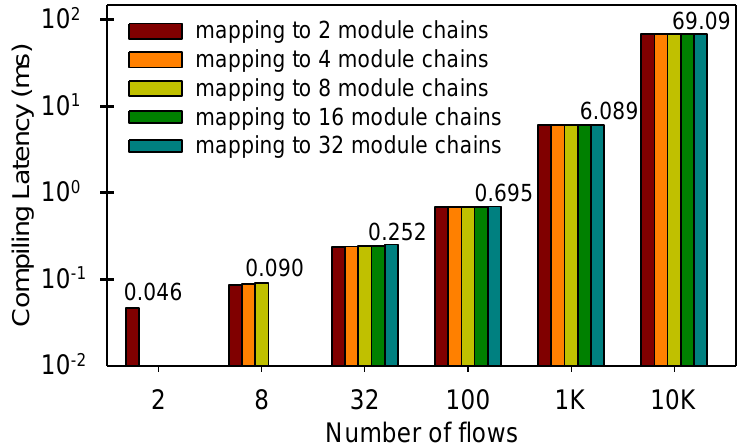
Figure 11. Compiling delay with different number of flows in each scheme. We list the maximum compiling delay in each number of